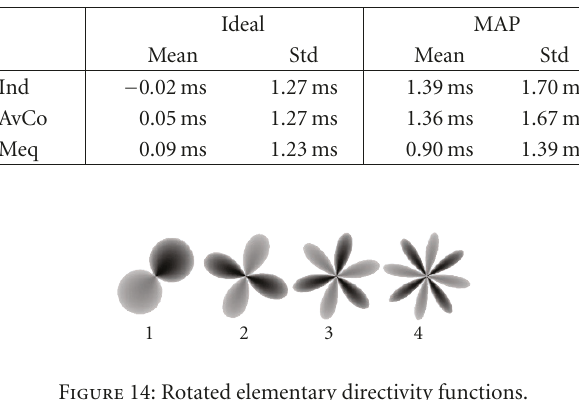
Table 1: Mean value and standard deviation GD ERB for all micro- phone positions, all source positions and degrees.